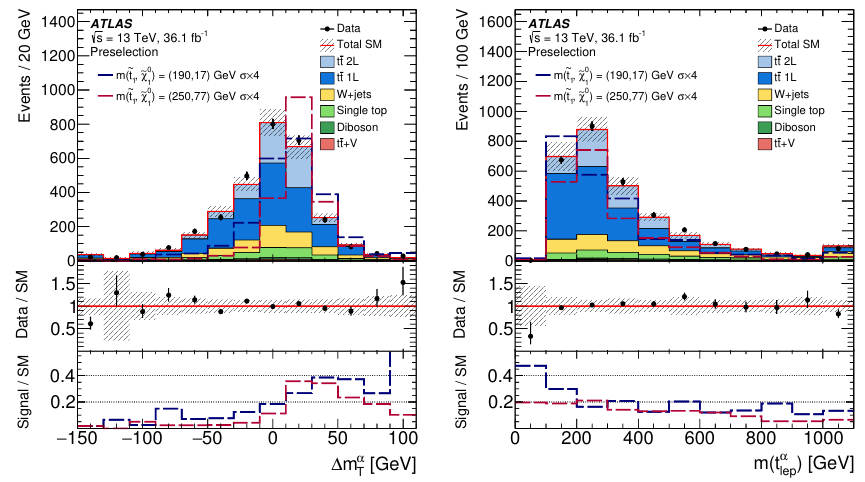
Figure 6 . Distributions of discriminating variables: (left) (cid:1) m (cid:11) in the tN diag low signal region, which is de(cid:12)ned in section 7.1.2. Preselection refers to the signal region selection but without any requirements on the BDT output score. In addition to the SM background prediction, signal models are shown, denoted by m (~ t four for visibility. The lower panels show the ratio of data to total SM background and the ratio of expected signal to total SM background. The hatched area around the total SM prediction and the hatched band in the Data/SM ratio include statistical and experimental uncertainties. The last bin contains